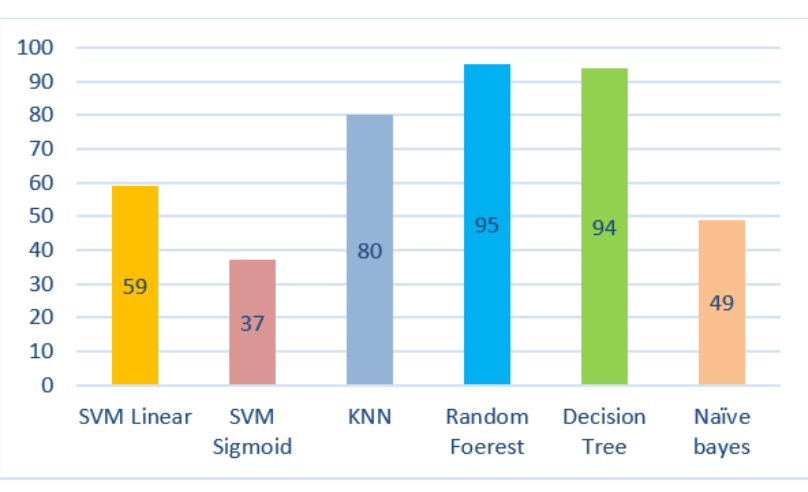
Figure 10. Classification Models Summary.